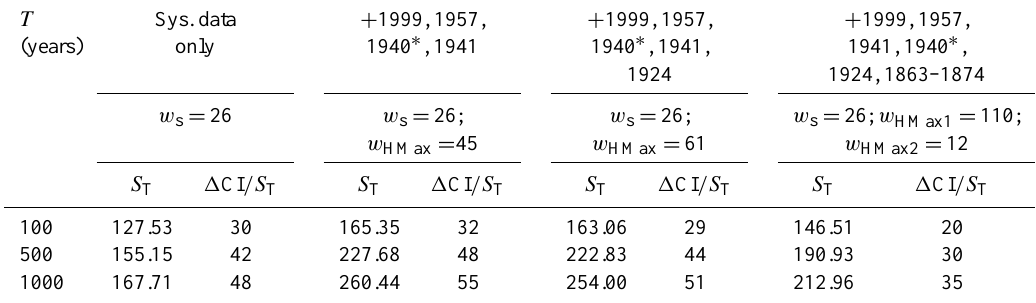
Table 5. The T -year quantiles (in cm) estimated on the basis of the systematic and historical periods and relative widths (in %) of their 70% confidence interval (the POTH frequency